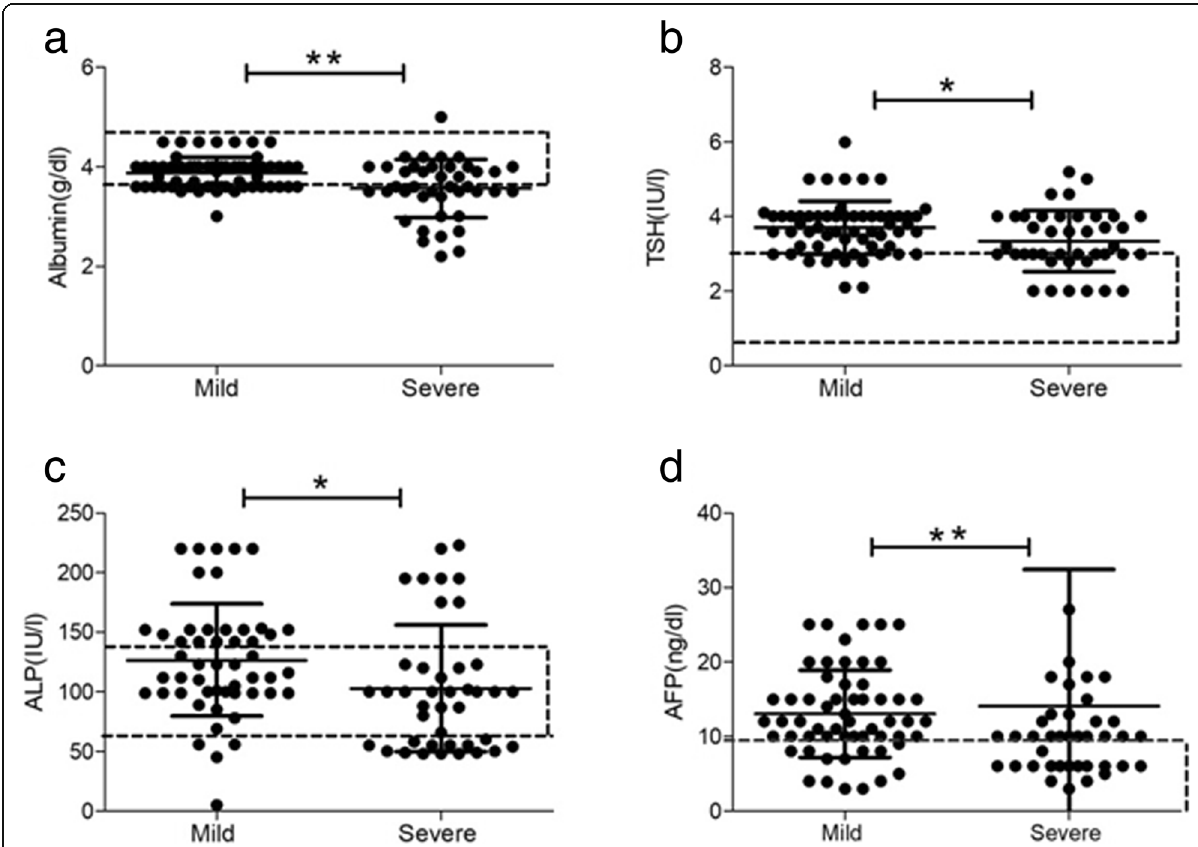
Fig. 2 Clinical parameters that significantly differ between the two studied groups. Mean level ± SD of albumin ( a ), TSH ( b ), ALP ( c ), and AFP ( d ). Dotted line represents the normal value in healthy individuals, 3.8 – 4.5 g/dL for albumin, 0.5 – 3.5 IU/L for TSH, 55 – 147 IU/L for ALP, and less than 10 ng/mL for AFP. * p < 0.05, ** p < 0.01, and *** p < 0.001. TSH thyroid-stimulating hormones, AFP alpha-fetoprotein, ALP alkaline